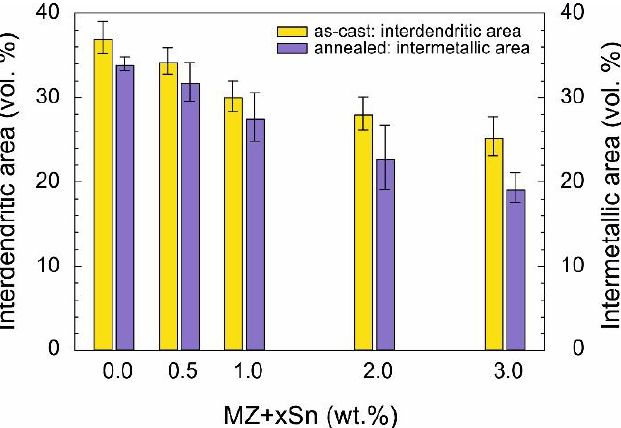
Figure 10. Vol.% of microstructural components as determined from SEM image analysis.